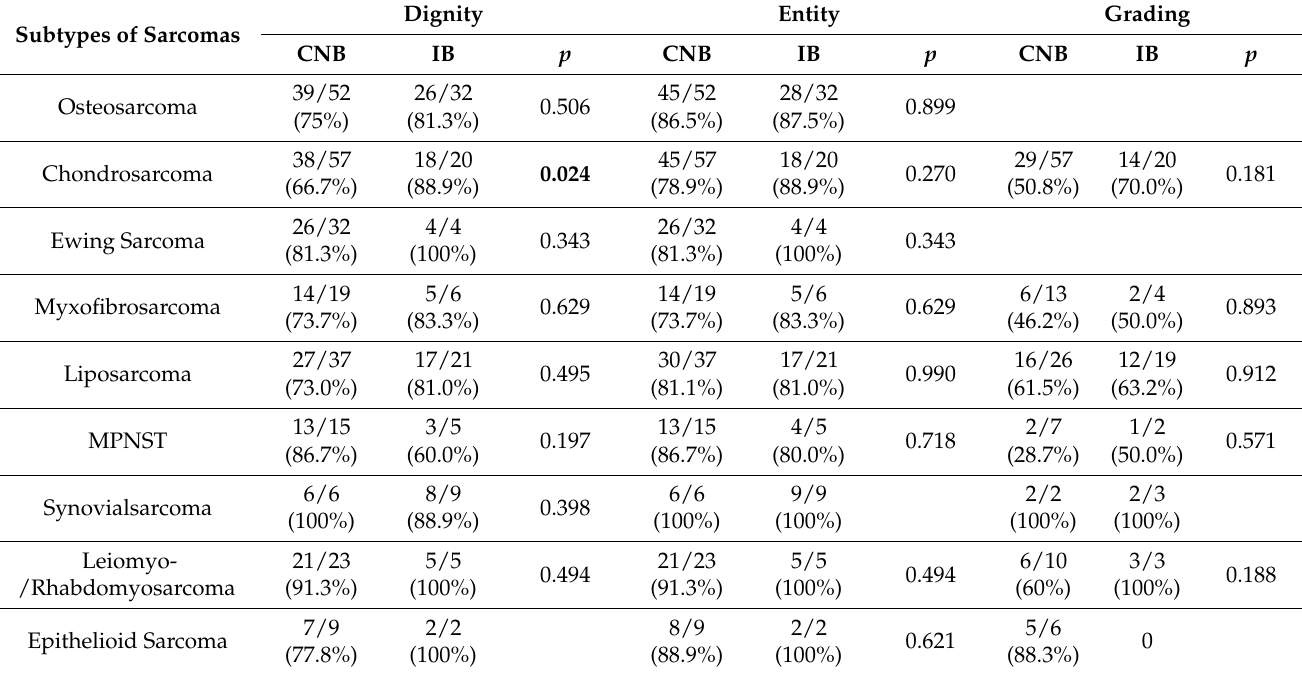
Table 1. Sensitivity of biopsy kinds in different subtypes of sarcomas (CNB: Core needle biopsy; IB: Incisional biopsy; bolded p -value is a significant difference, p <